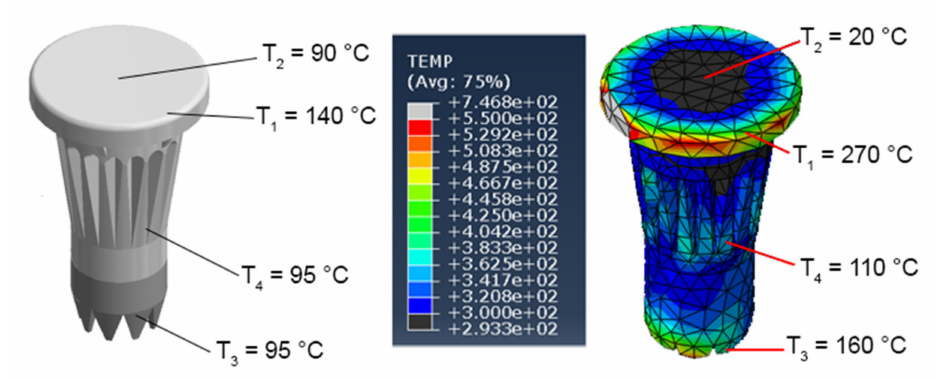
Figure 11. Temperature measurement after the insertion and pulling out and simulated temperature after the